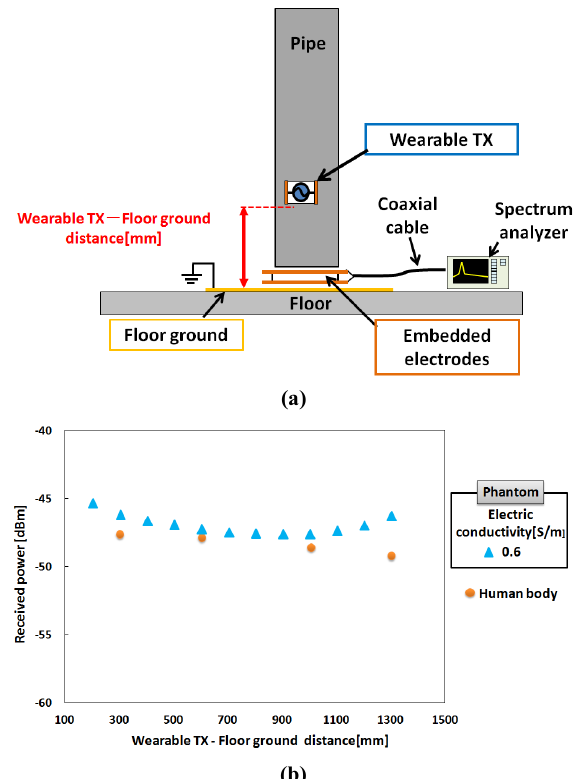
Figure 5. (a) experimental system to evaluate surface propagation of main signal (b) results of experiment.